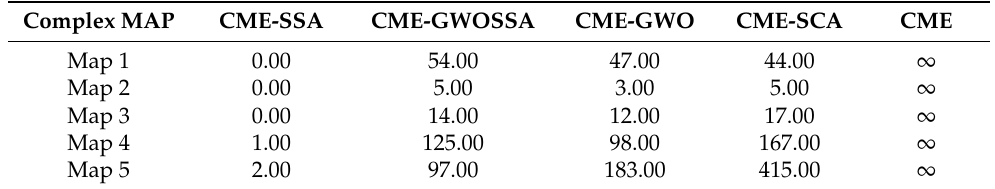
Table 8. The number of failed simulations to complete 100 iterations of the hybrid exploration methods on five complex environment